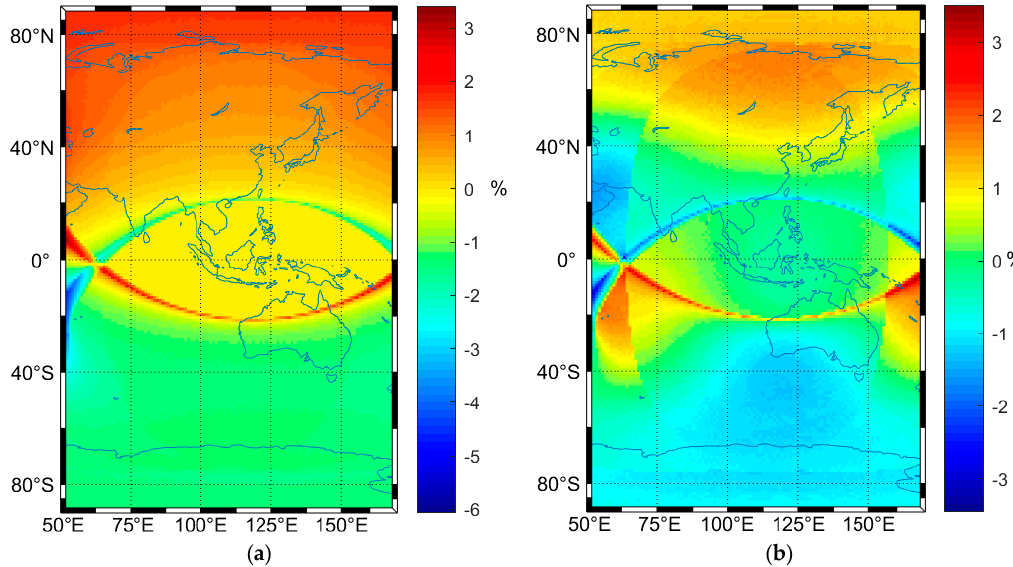
Figure 5. The performance improving rates (%) of BDS-3 + QZO relative to the BDS-3 constellation in area of 90 ◦ S–90 ◦ N and 50 ◦ E–170 ◦ E. ( a ) Satellites visibility improving rates of BDS-3 + QZO relative to BDS-3; ( b ) GDOP improving rates of BDS-3 + QZO relative to BDS-3